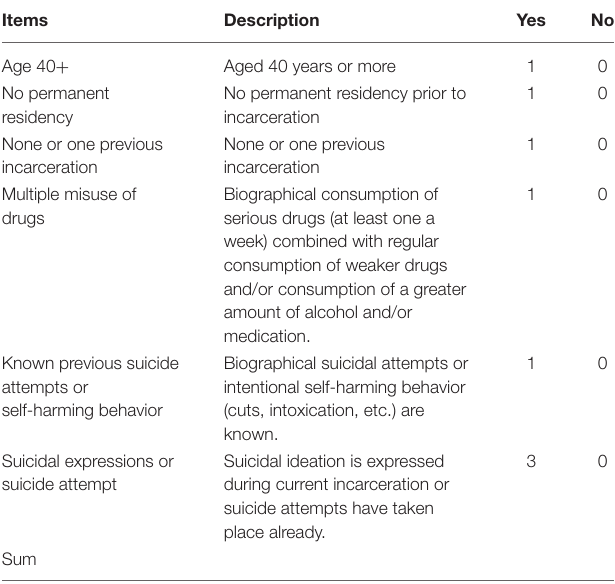
TABLE 1 | Description of screening items and